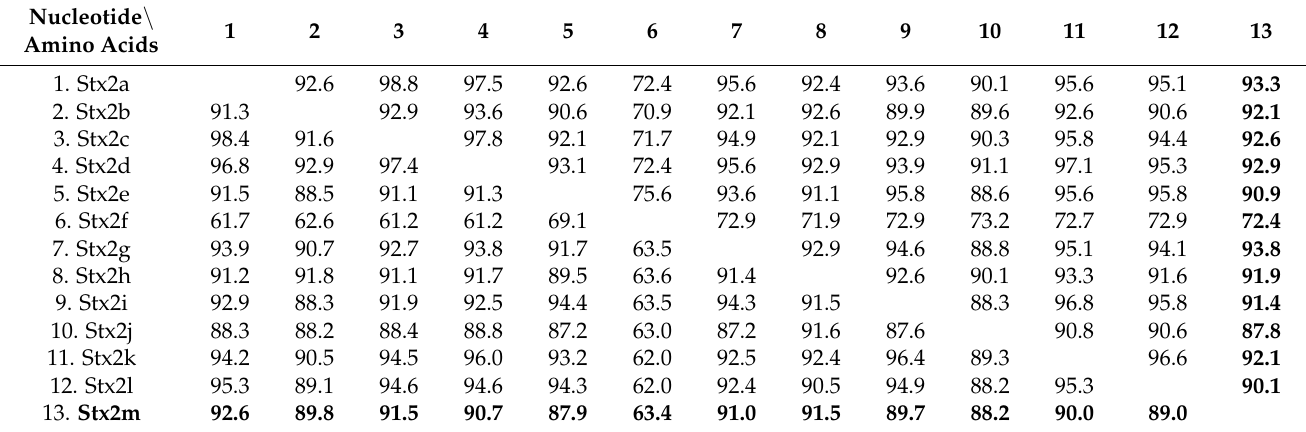
Table 2. Nucleotide\amino acids identities (%) between Stx2m and representatives of other described Stx2 subtypes. Nucleotide\ Amino Acids